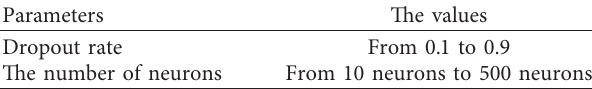
Table 1: The value range for hyperparameter.